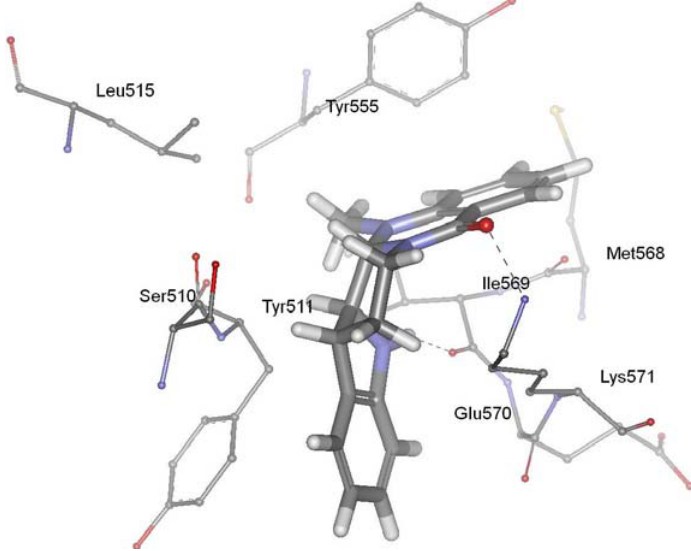
Figure 4. Binding mode of evodiamine in the active site of vanilloid receptor